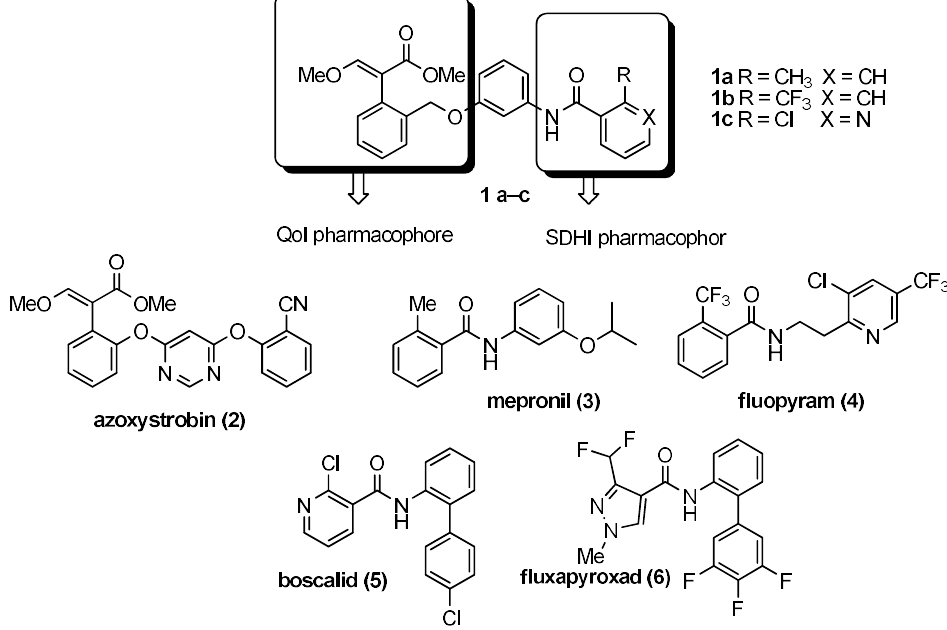
Figure 1. First generation of dual compounds 1a–c [18], commercial strobilurins ( 2 ), and succinate dehydrogenase inhibitors (SDHIs) ( 3 – 6 ), chosen as templates.